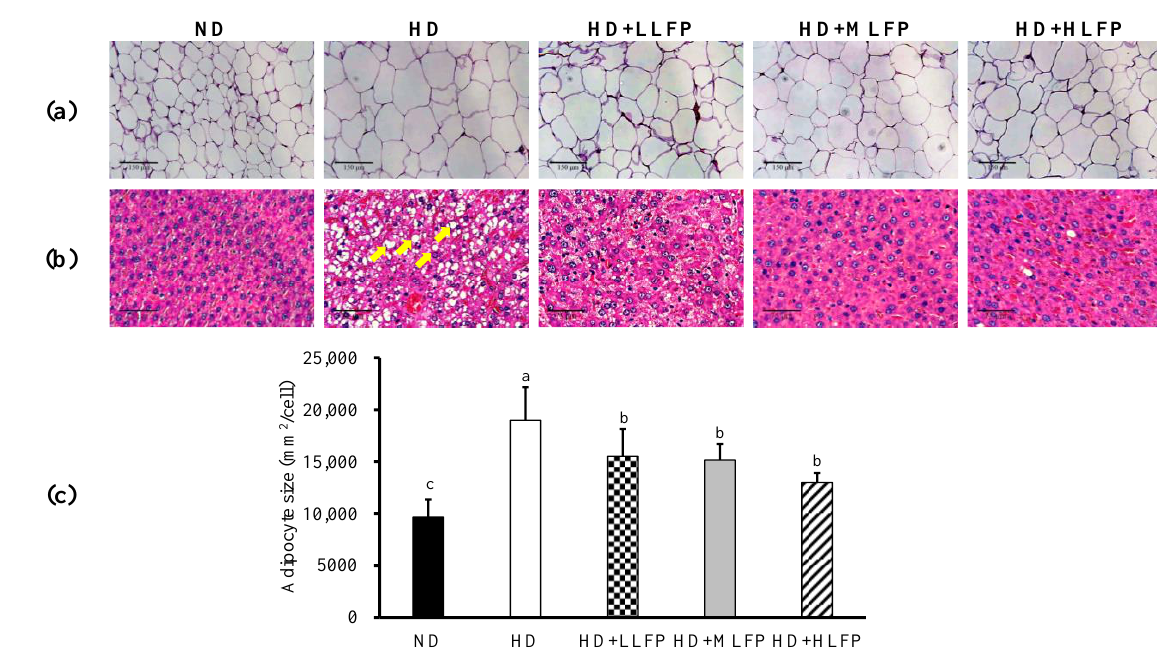
Figure 5. Effects of LFP on histological in epididymal adipose tissue and liver of rats a fed high-calorie diet. ( a ) Epididymal adipose tissues, ( b ) liver, and ( c ) adipocyte size. Epididymal adipose tissues and liver were stained with hematoxylin and eosin and were viewed under a microscope ( × 200). The significance of difference in adipocyte size was evaluated by Duncan’s test. Data are the means ± SD ( n = 5). Different letters (a–c) indicate that the adipocyte size was statistically different from each other ( p < 0.05). The groups are abbreviated as: Normal diet (ND), high calorie diet (HD), HD with low